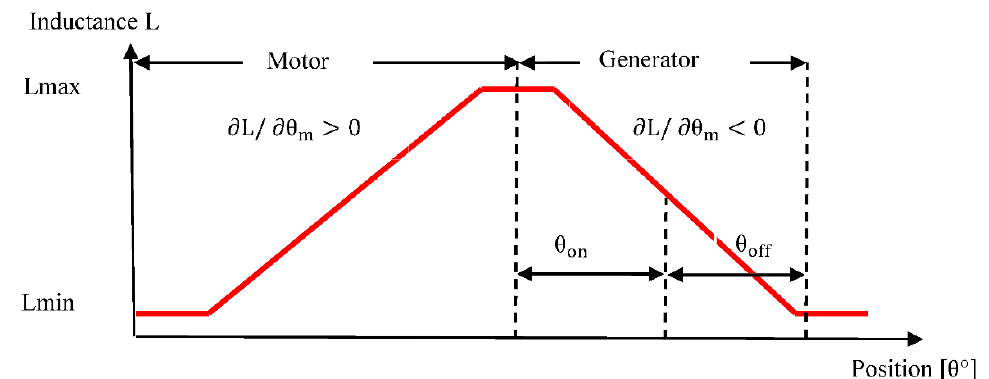
Figure 2. SRM operation principle.